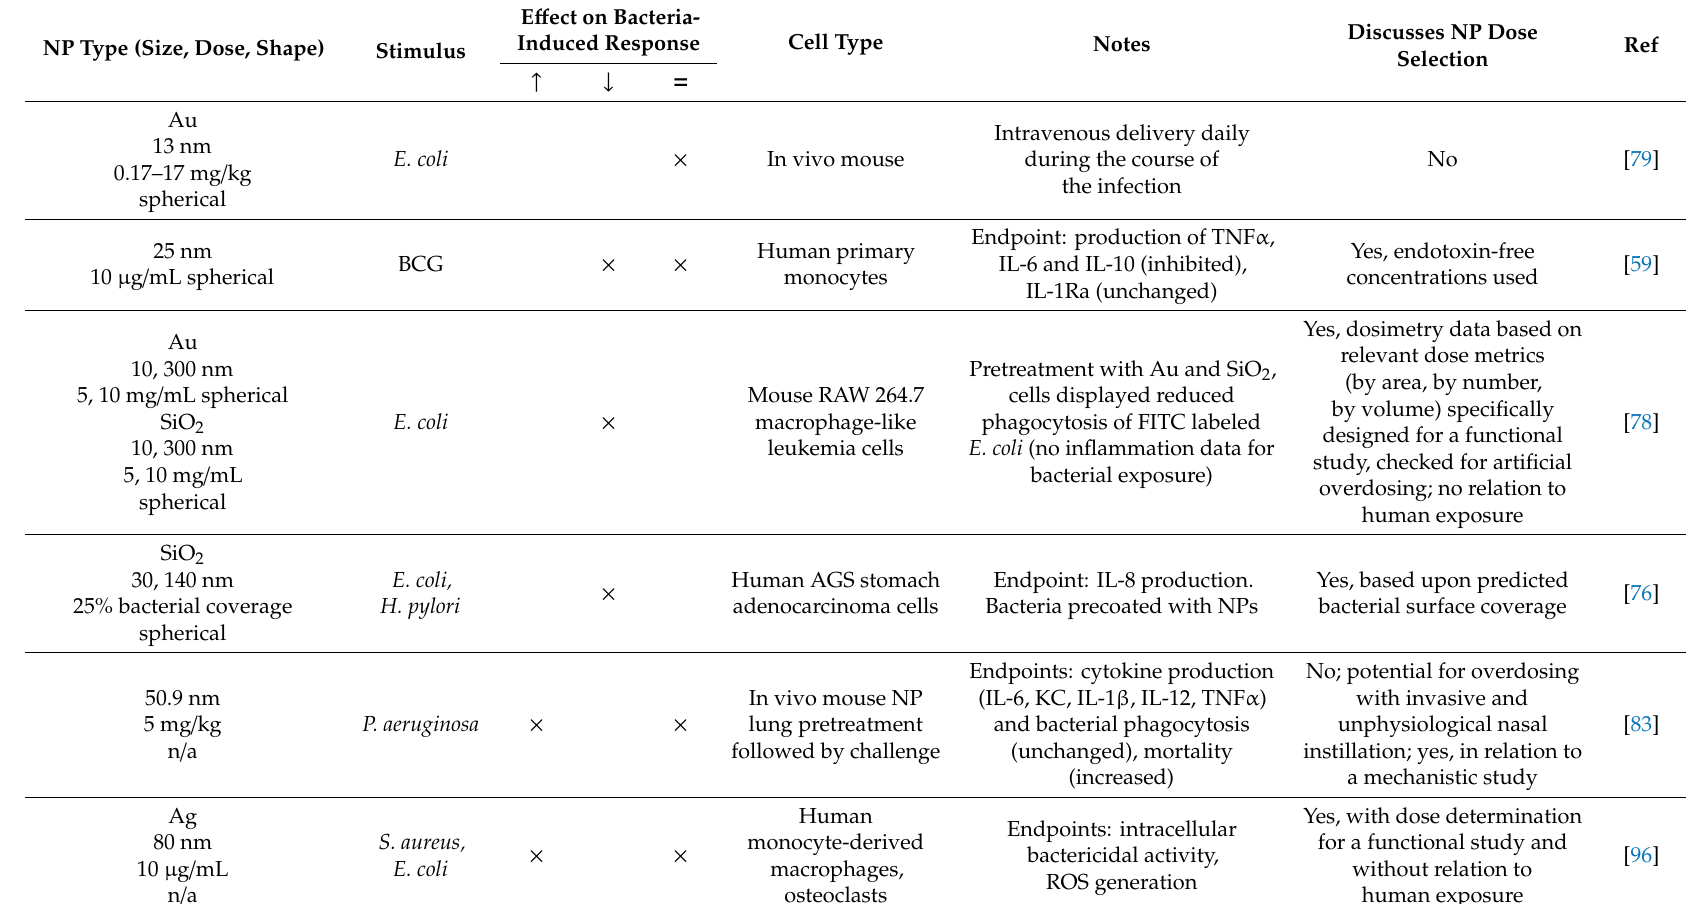
Table 2. Overview on studies on the impact of NPs on innate immune stimulation by live